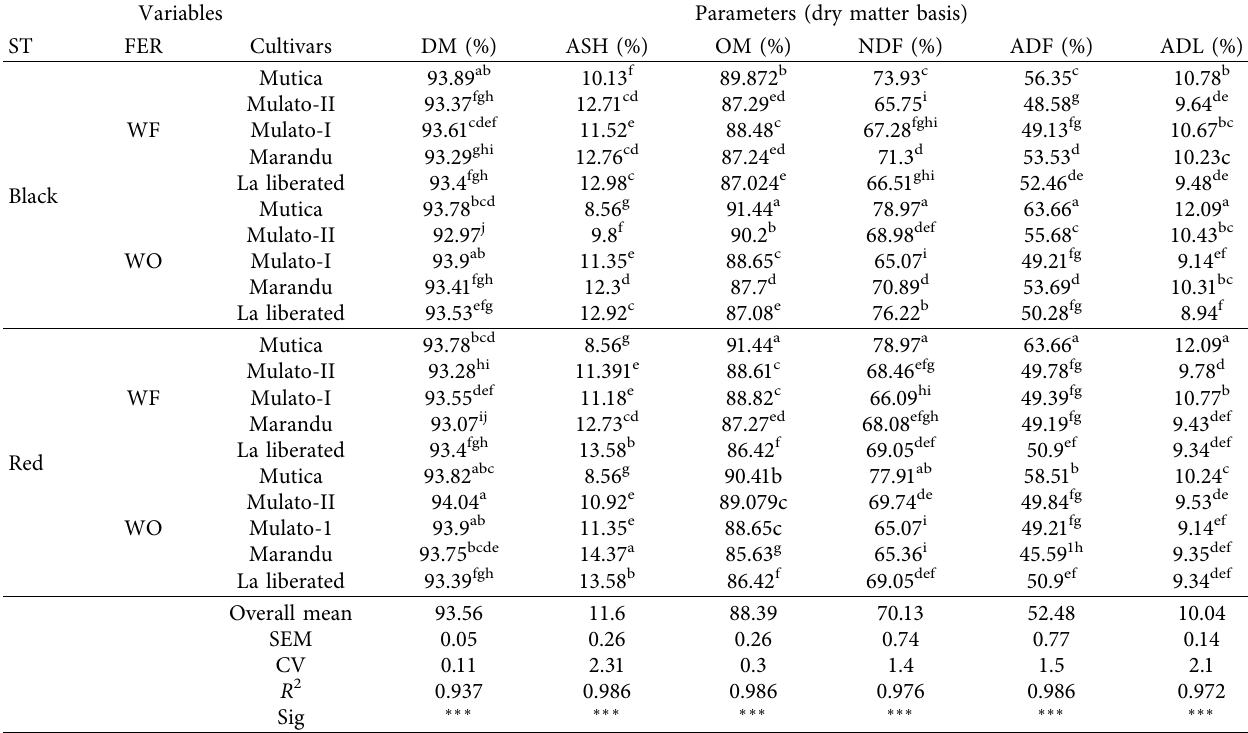
Table 3: Efect of fertilizer, soil type and cultivars on chemical composition of Brachiaria cultivars .